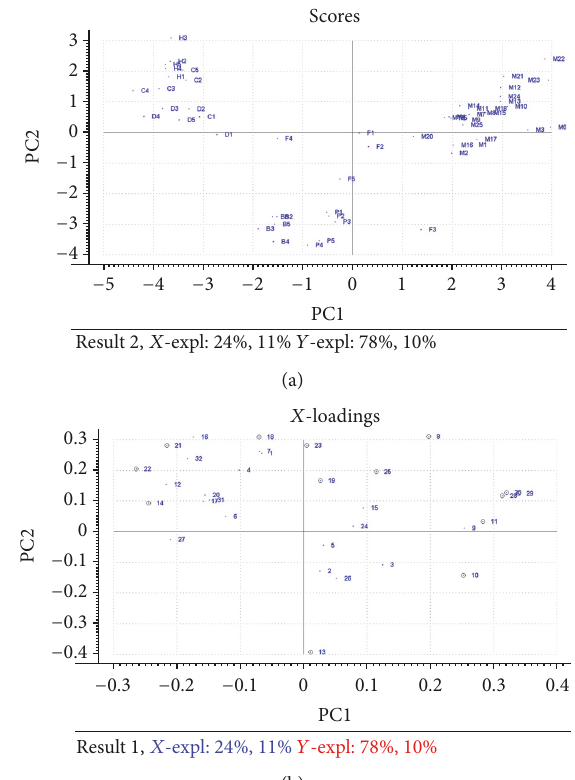
Figure 3: PLS-DA scores (a) and loadings (b) plots among mutton samples, fraud samples, and other meats. The labels of the samples correspond to the code in Figure 1. The labels of the loadings correspond to the code in Table 1.